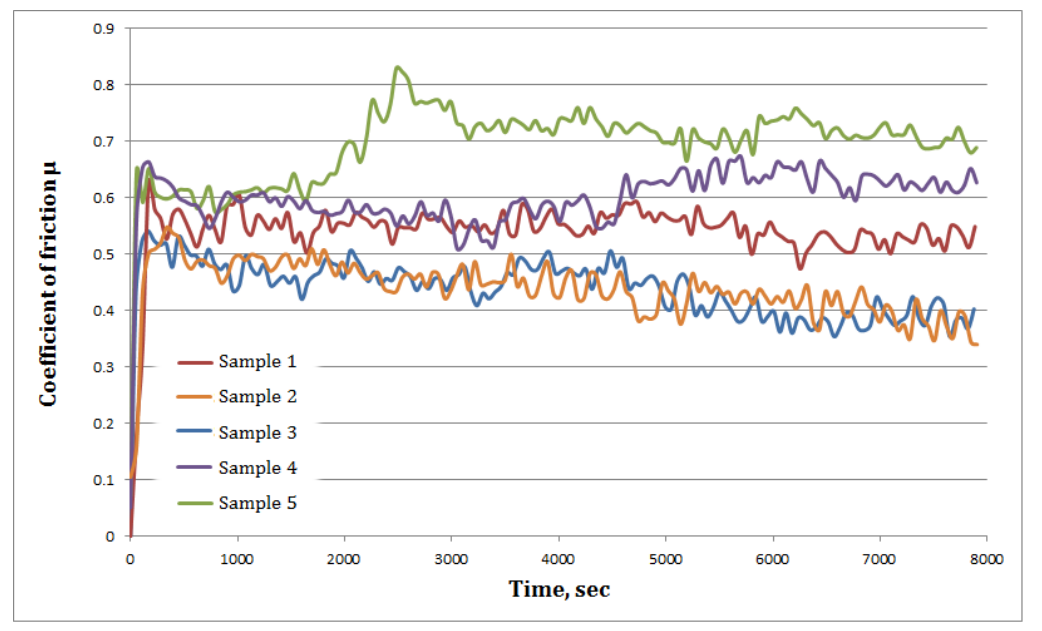
Figure 7. CoF evolution in time. Table 5. Sliding wear test